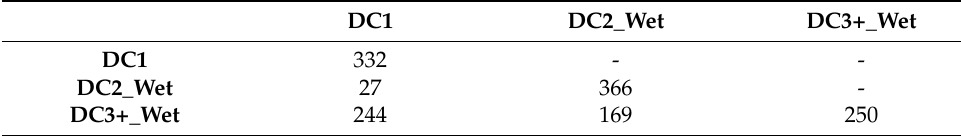
Table 12. Variance components estimates used to calculate Index three.